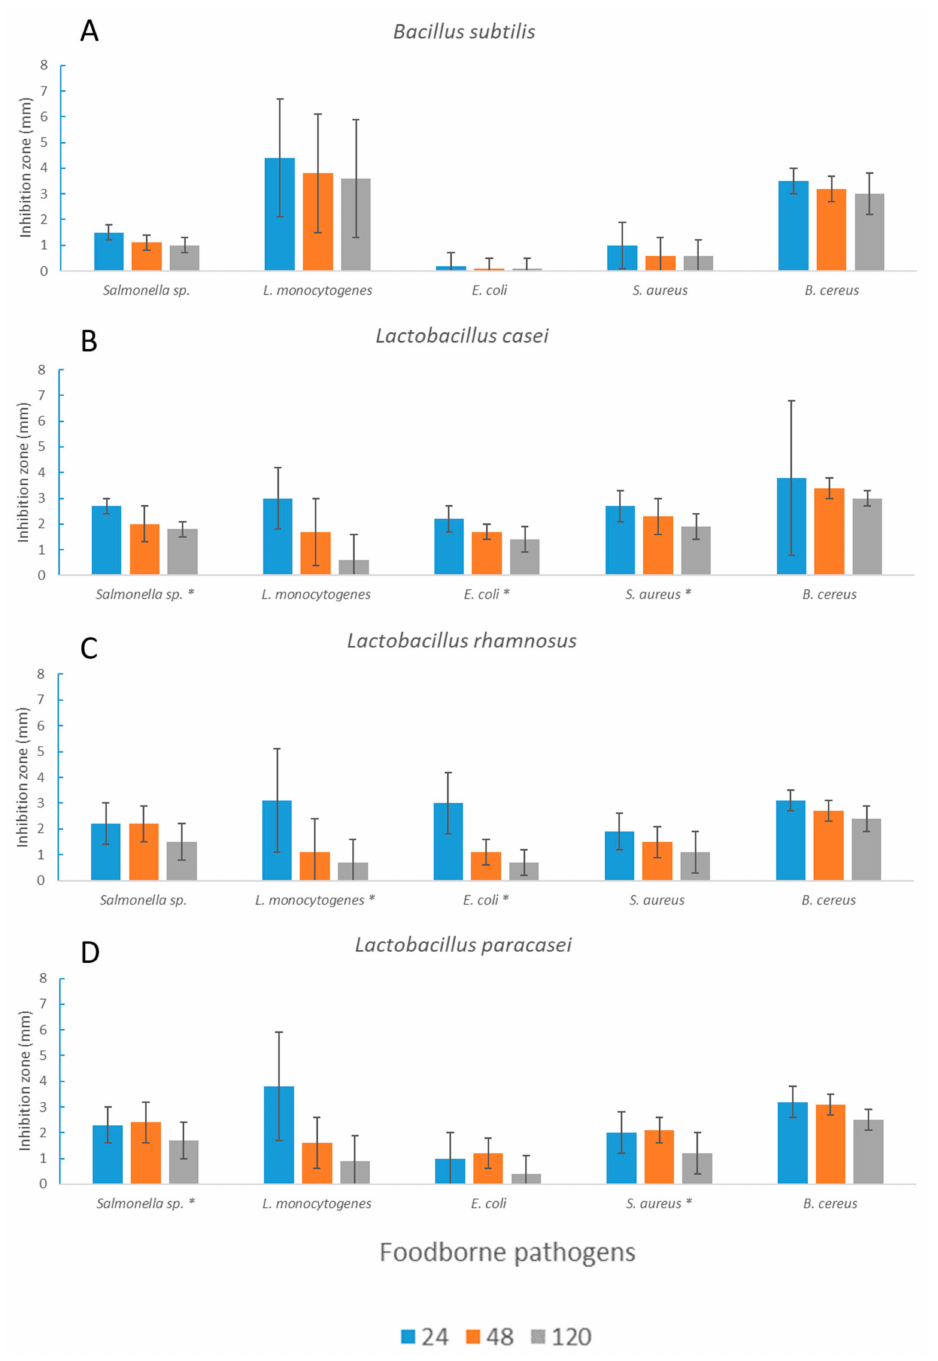
Figure 3. Inhibition radius (mm) of fermented HE I extracts after 24 h of fermentation. Measurements were taken after 24, 48, and 120 h. Average values ± standard deviations are reported. Here, * expresses the significance ( p < 0.05) of H. elongata fermented with B. subtilis , A, and the same seaweed fermented with the L. casei group ( L. casei , B, L. rhamnosus , C, and L. paracasei , D) of